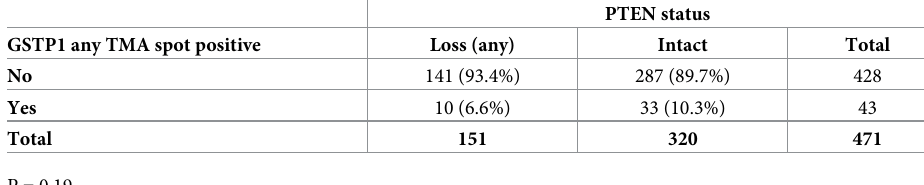
Table 7. GSTP1 protein staining by PTEN loss overall.